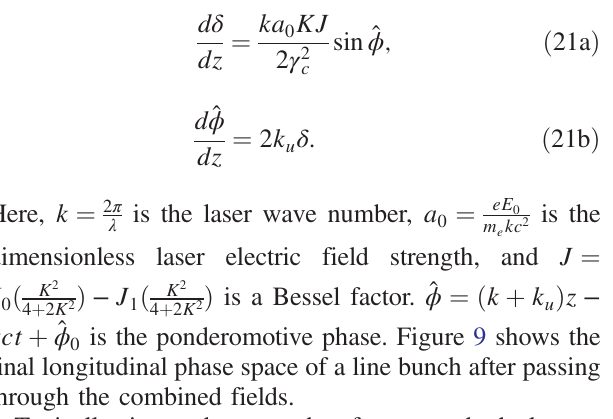
FIG. 9. Longitudinal phase space at the exit of the laser modulator under various laser strength. The initial state is a line bunch without energy deviation. As the modulation laser strength grows, electrons rotate and form the FEL bucket, but the linear region around the zero-cross point shrinks. The blue dotted line is the tangent at the zero-cross point, the gray dotted line represents the deviation between modulated result and the linear tangent line. (a) a 0 ¼ 3 . 9 × 10 − 6 ; (b) a 0 ¼ 5 . 8 × 10 − 5 ; (c) a 0 ¼ 1 . 9 × 10 − 4 ; (d) a 0 ¼ 3 . 9 × 10 − 4 . The laser wavelength used is λ ¼ 1 μ m, which is the fundamental resonant wavelength of the undulator with λ u ¼ 5 cm, and wiggler periods N u ¼ 50